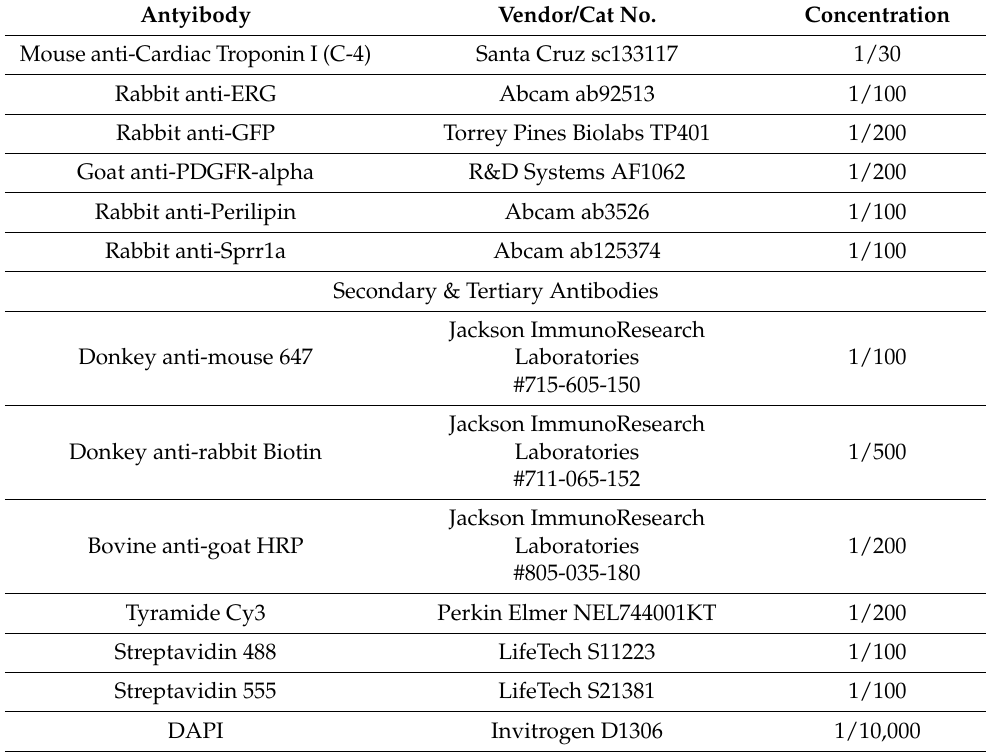
Table 1. Antibody